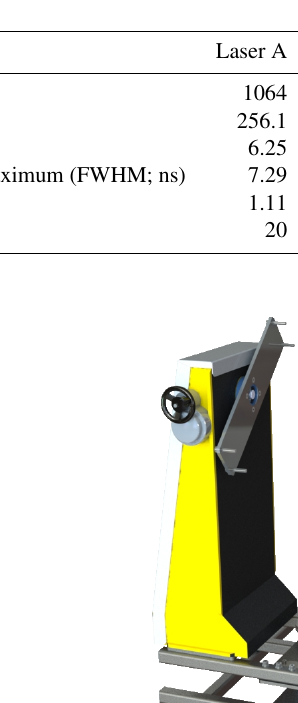
Table 1. Laser A and B parameters.